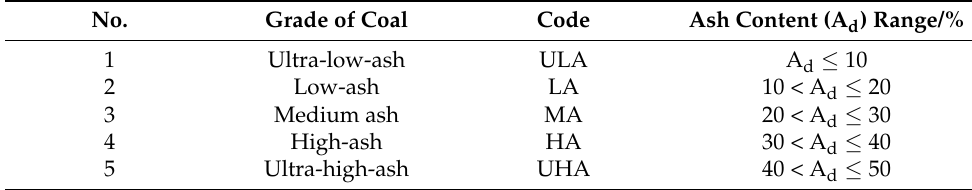
Table 2. Classification of coal ash content in China.